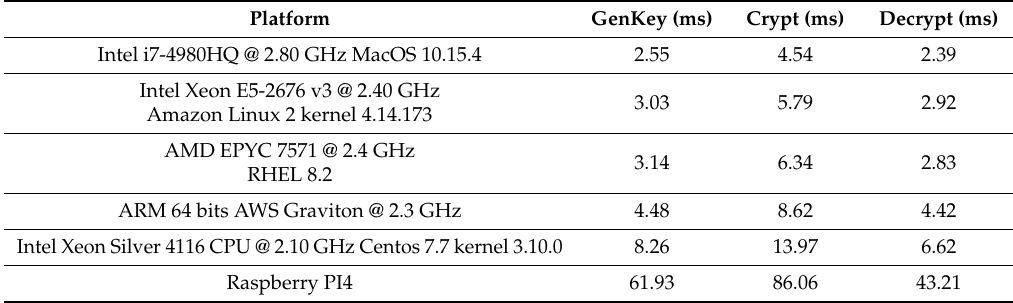
Table 9. Elliptic Curve Integrated Encryption Scheme (ECIES) execution time on di ff erent client and server platforms.